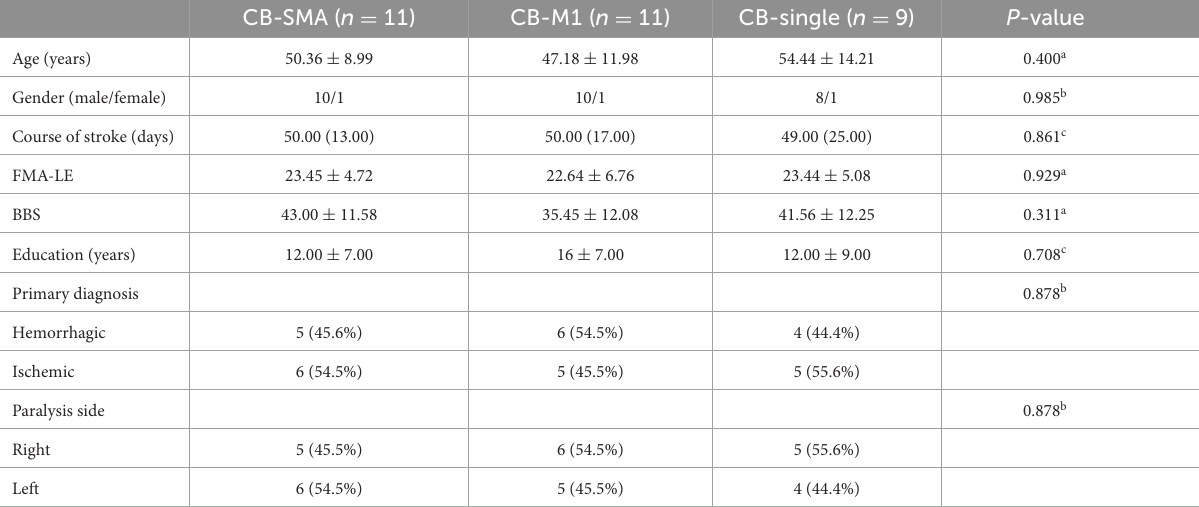
TABLE 2 Baseline characteristics of the three patients’